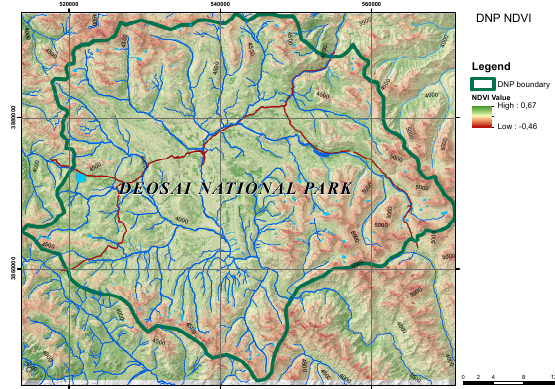
Figure 2. Normalized Difference Vegetation Index